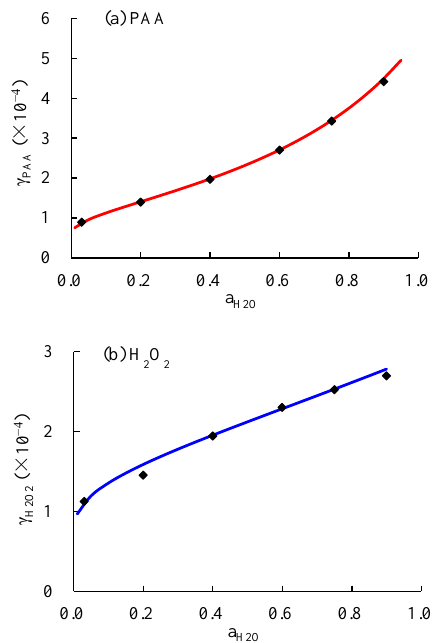
Figure 4. The uptake coefficients of PAA and H 2 O 2 on PM 2 . 5 par- ticles. The red line and the blue line in (a) and (b) represent the empirical fit of γ PAA and γ H , respectively. 2 O 2